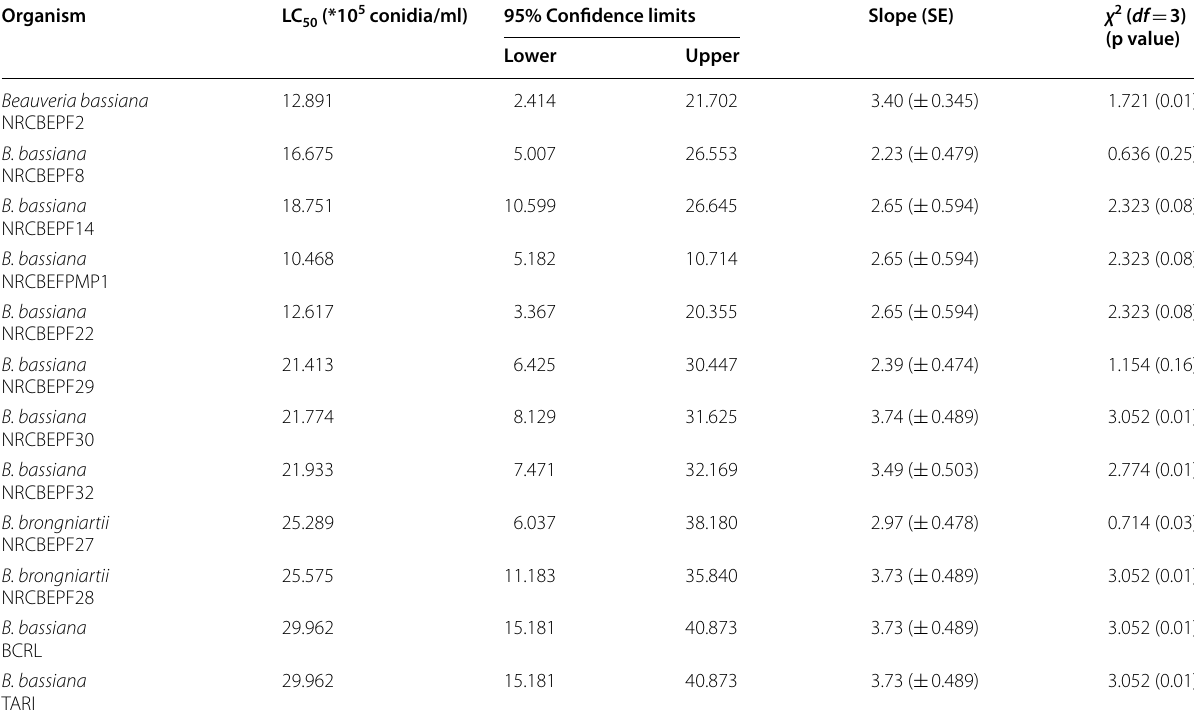
LC 50 estimated concentration that causes 50% mortality (SPSS version 25); χ 2 (covariates X are transformed using the base 10.000 logarithm)